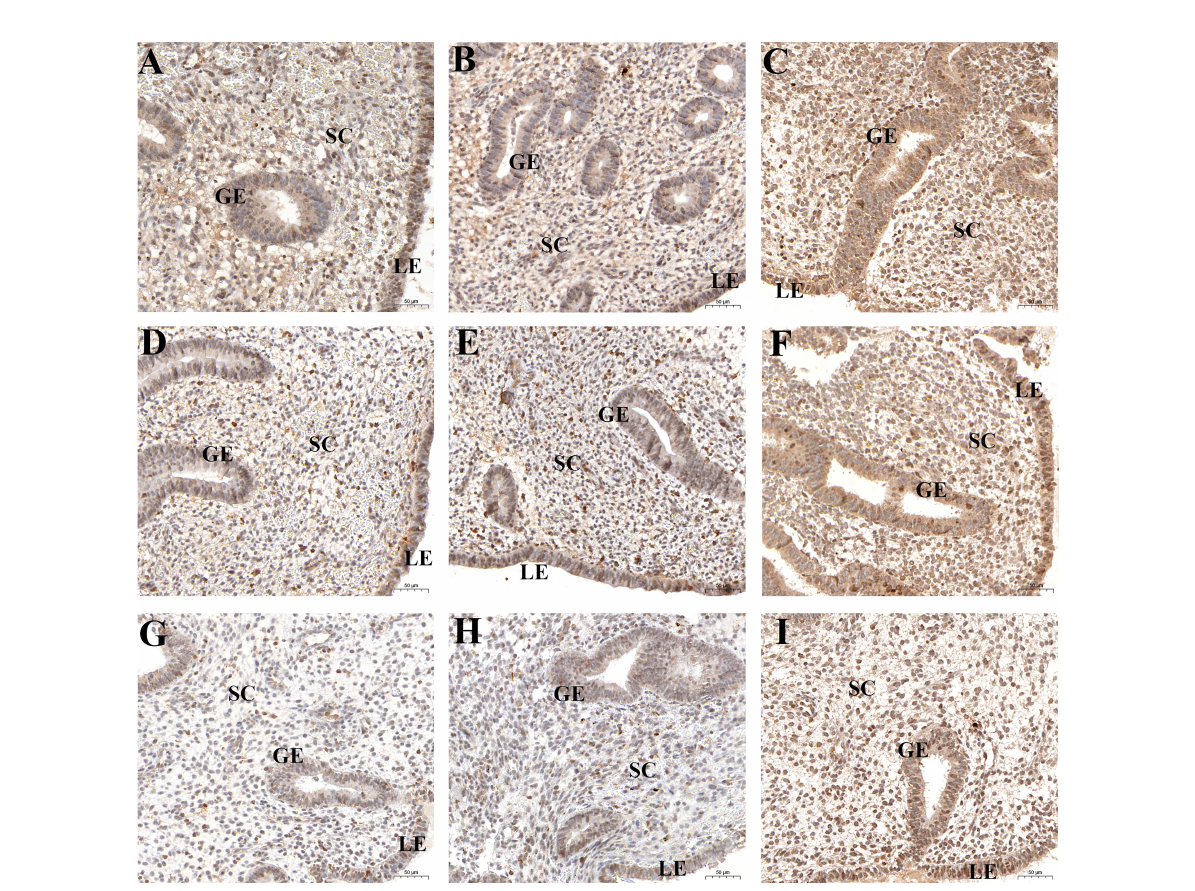
FIGURE 3 Spatial levels of HIF1 a (A-C) , VEGFA (D-F) , and VEGFR2 (G-I) in peri-implantation endometrium from the fertile controls (A, D, G) , CD138+ 1 – 4/ HPF group (B, E, H) , and CD138+ ≥ 5/HPF group (C, F, I) . Original magni fi cation, ×200. Scale bar = 50 m m. GE: glandular epithelium; LE: luminal epithelium; SC: stromal